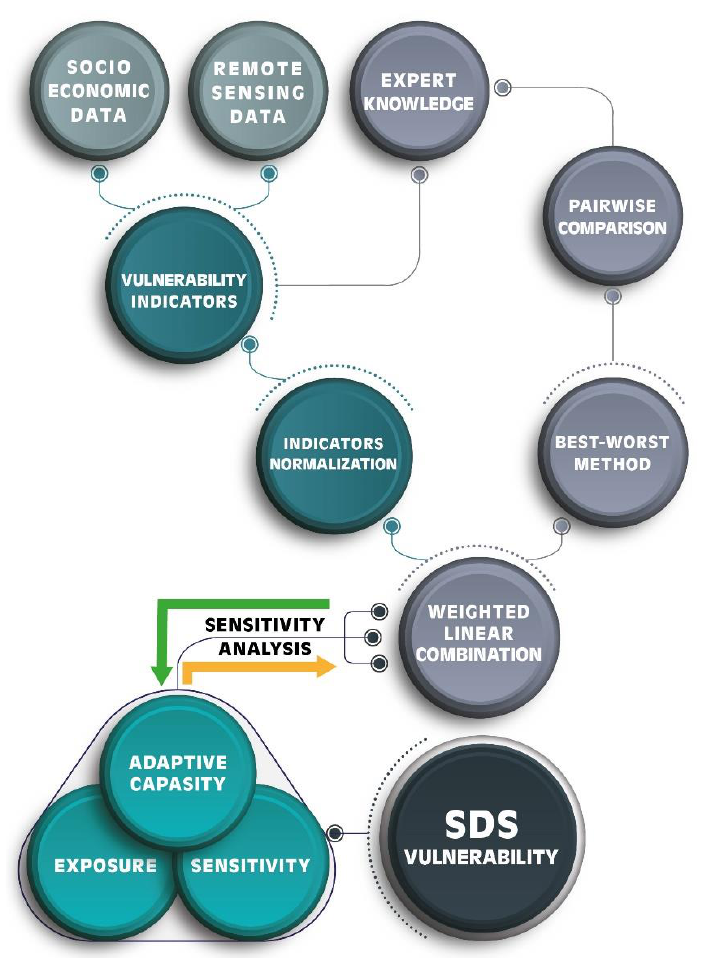
Figure 1. Methodology developed to assess the vulnerability of rural areas to sand and dust